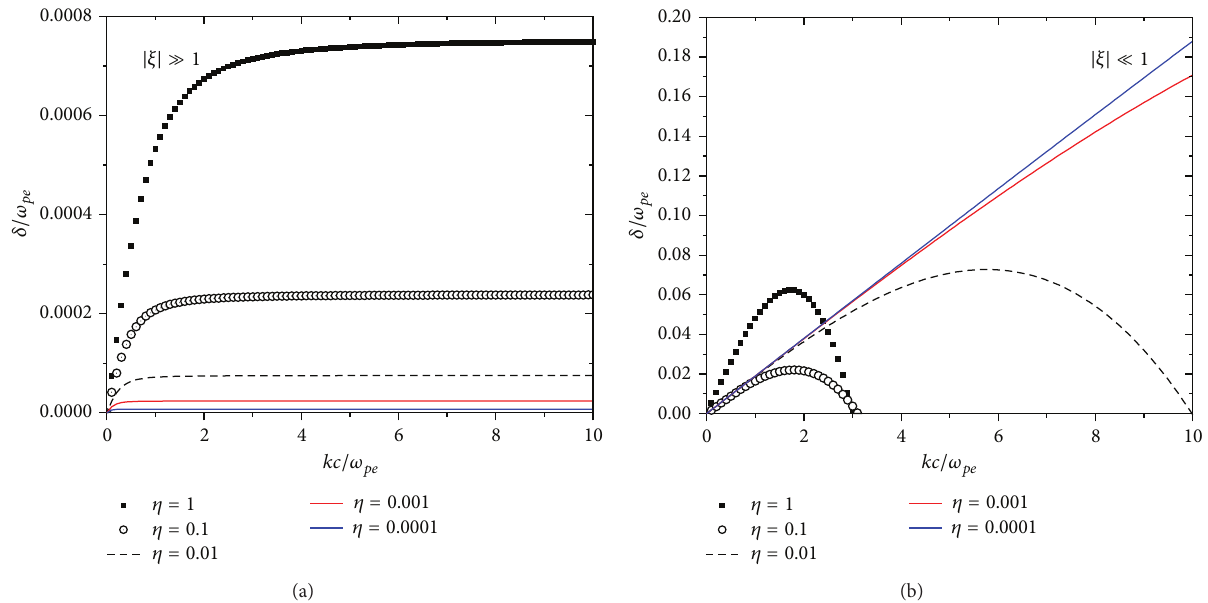
Figure 2: The growth rate of the Weibel instability, 𝛿/𝜔 𝑝𝑒 , as a function of wavenumber, 𝑘𝑐/𝜔 𝑝𝑒 , for the fixed density gradient, 𝜂 , (a) for the large wavelengths, (b) for the small wavelengths.